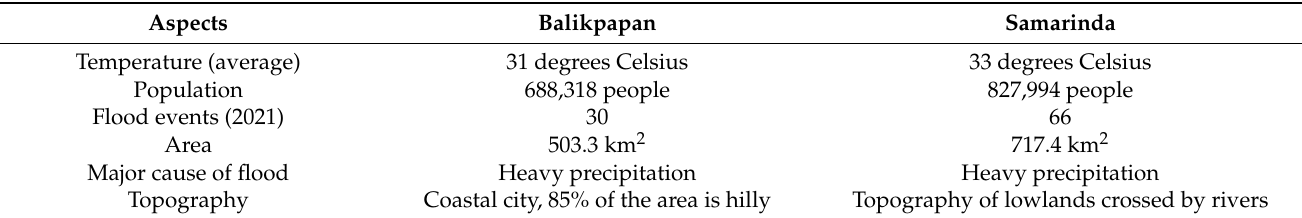
Table 2. Selected city characteristics.